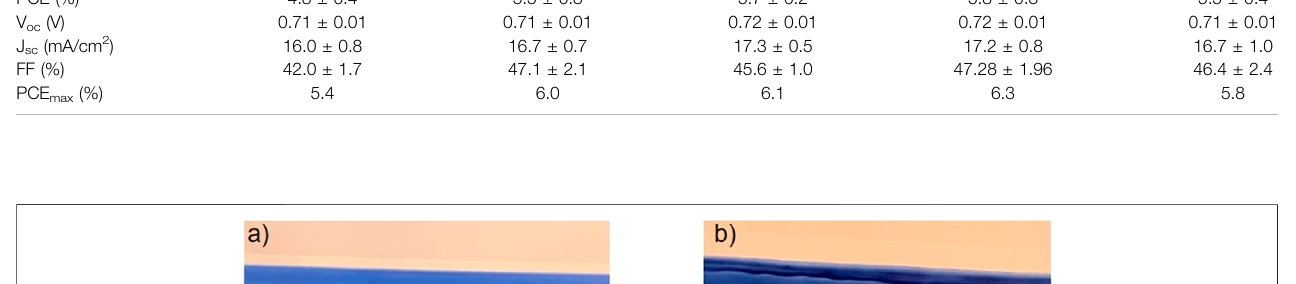
TABLE 2 | PV parameters for PM6:Y6-based OSCs devices prepared with different active layer thicknesses. The averages are obtained from eight devices. Active Layer Thickness (nm)